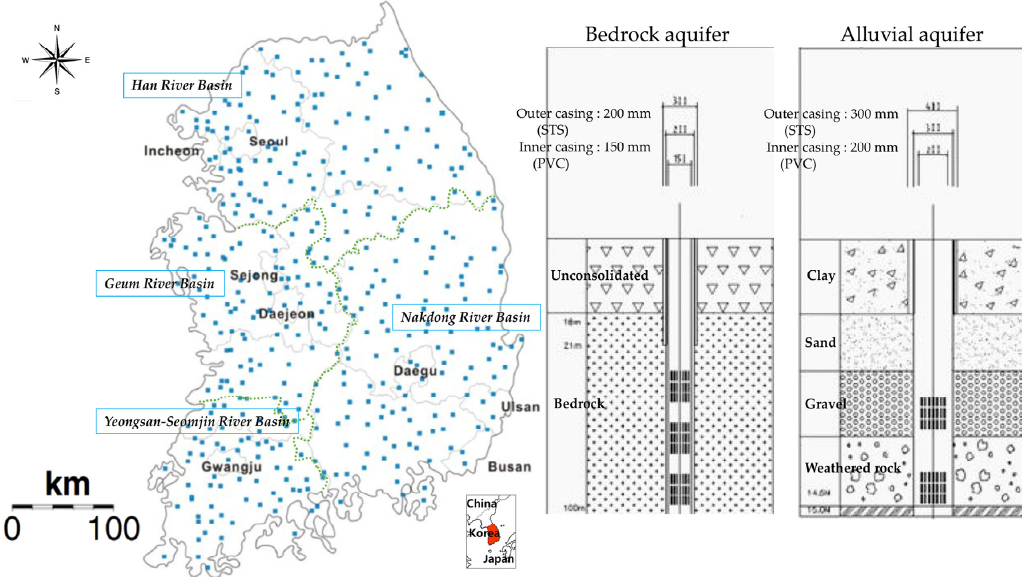
Figure 1. Locations and schematic diagrams of the National Groundwater Monitoring Stations (modified from [2], www.gims.go.kr).